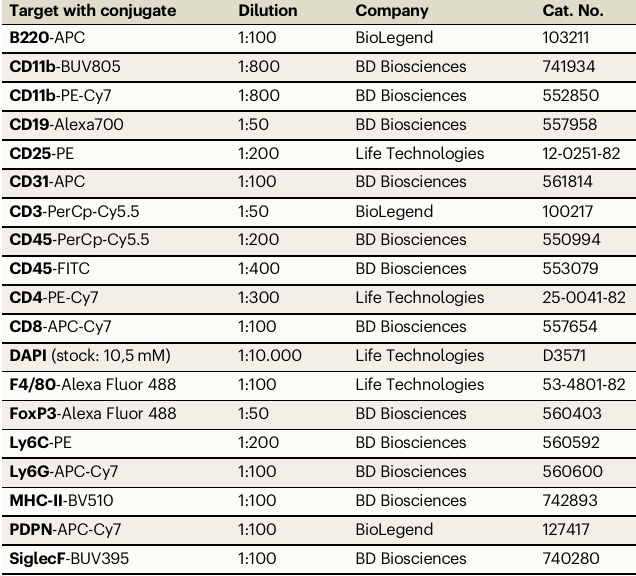
Table 2 | Flow cytometry and cell sorting antibodies Target with